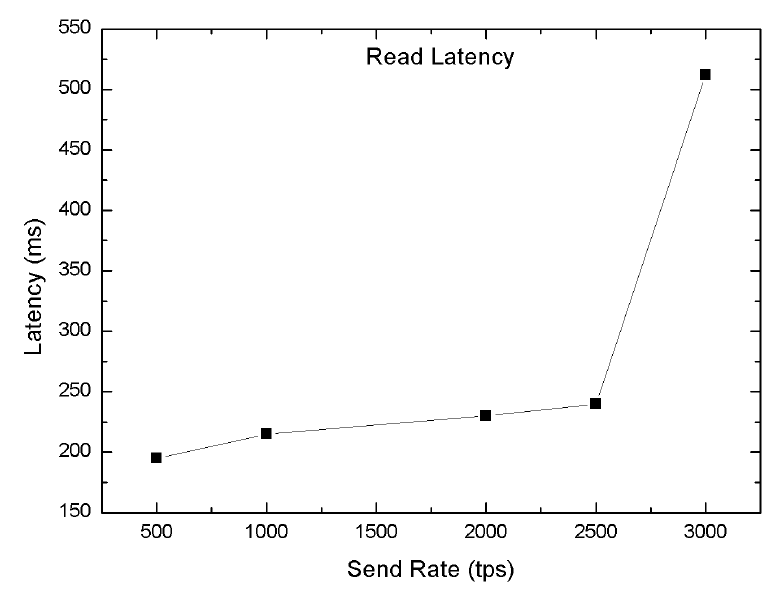
Figure 15. Average read latency.